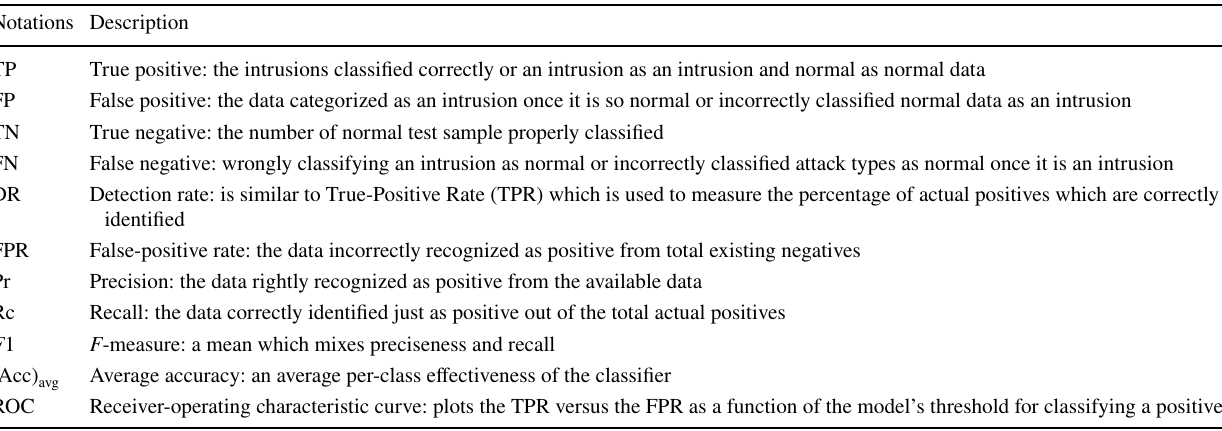
Table 2 The description of